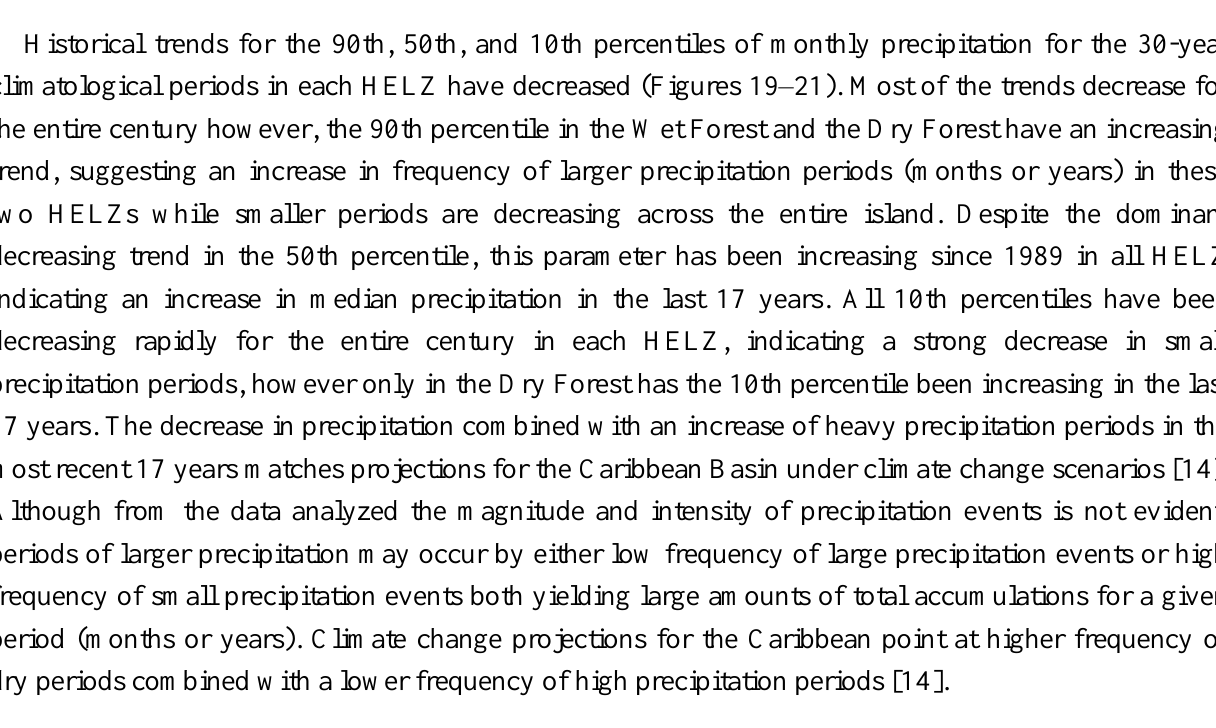
Figure 18. Seasonal monthly total precipitation by